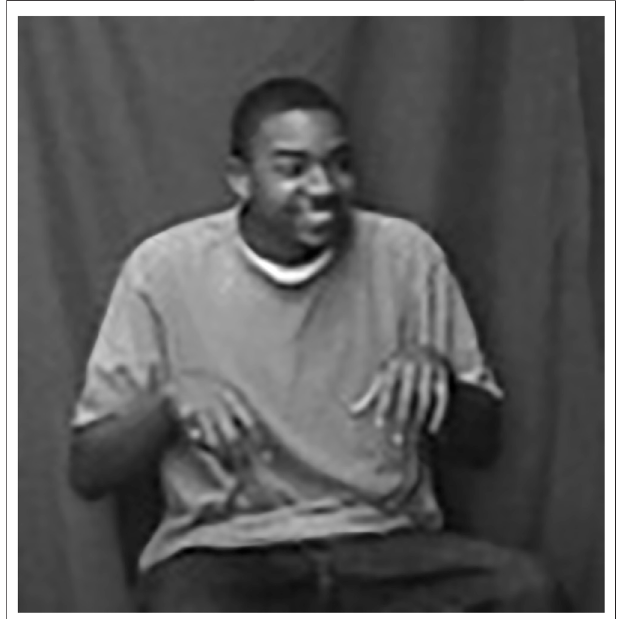
FIGURE 3 | Character Viewpoint